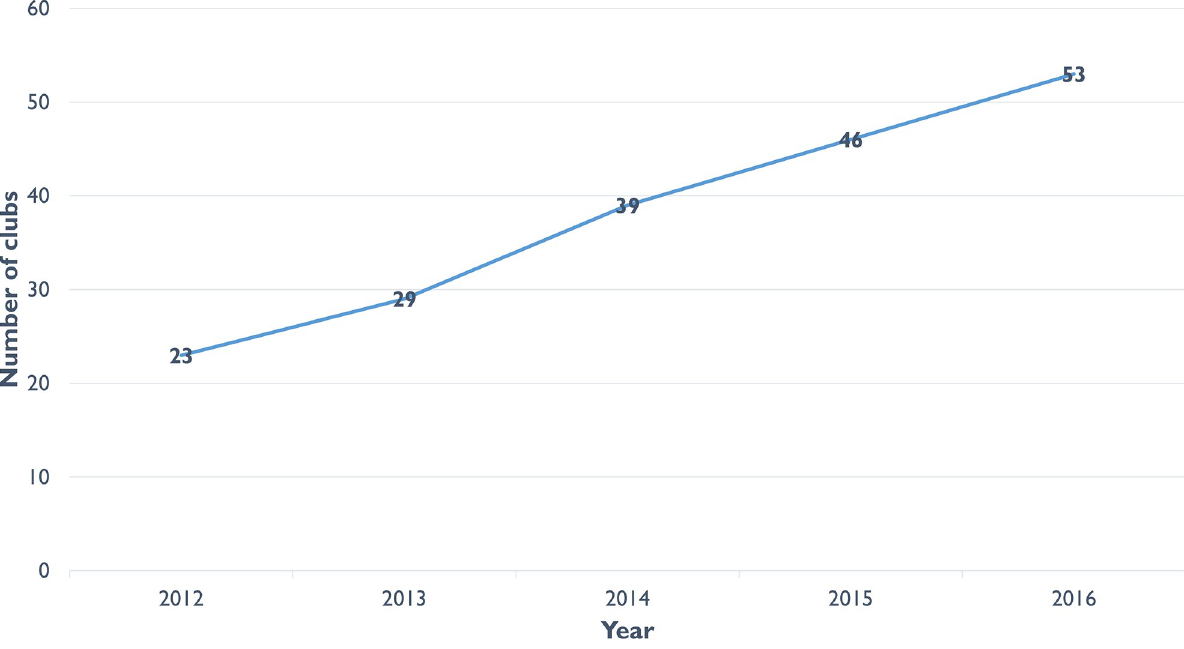
Fig 2. Number of adherence clubs, which opened from 2012 to 2016 at Facility